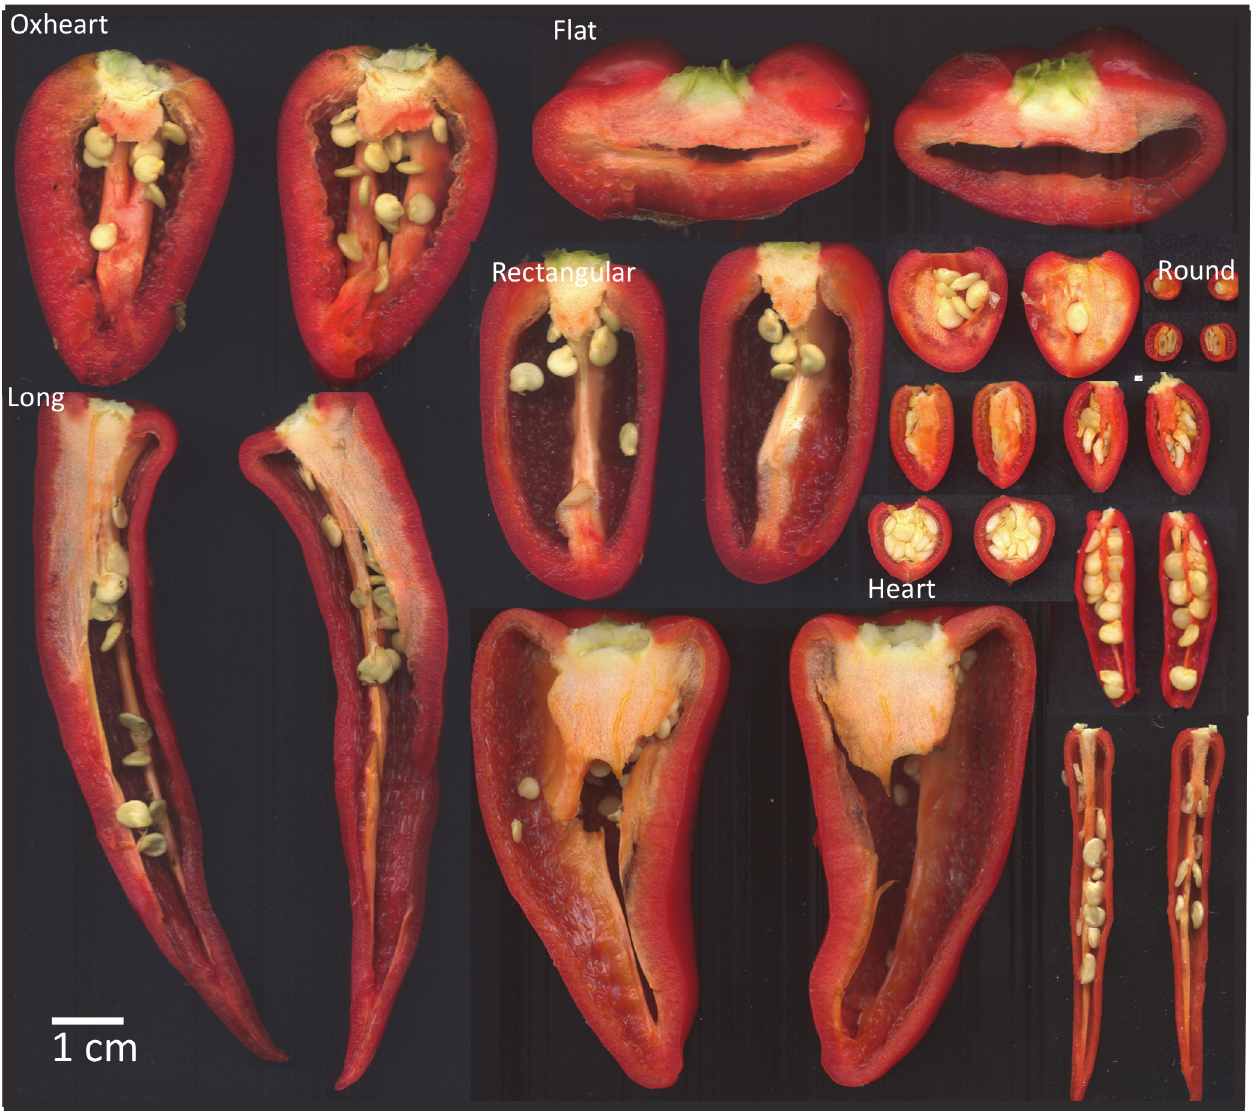
Fig 1. Mature pepper fruit phenotypic diversity in size, shape, end shape, and pericarp thickness of a worldwide